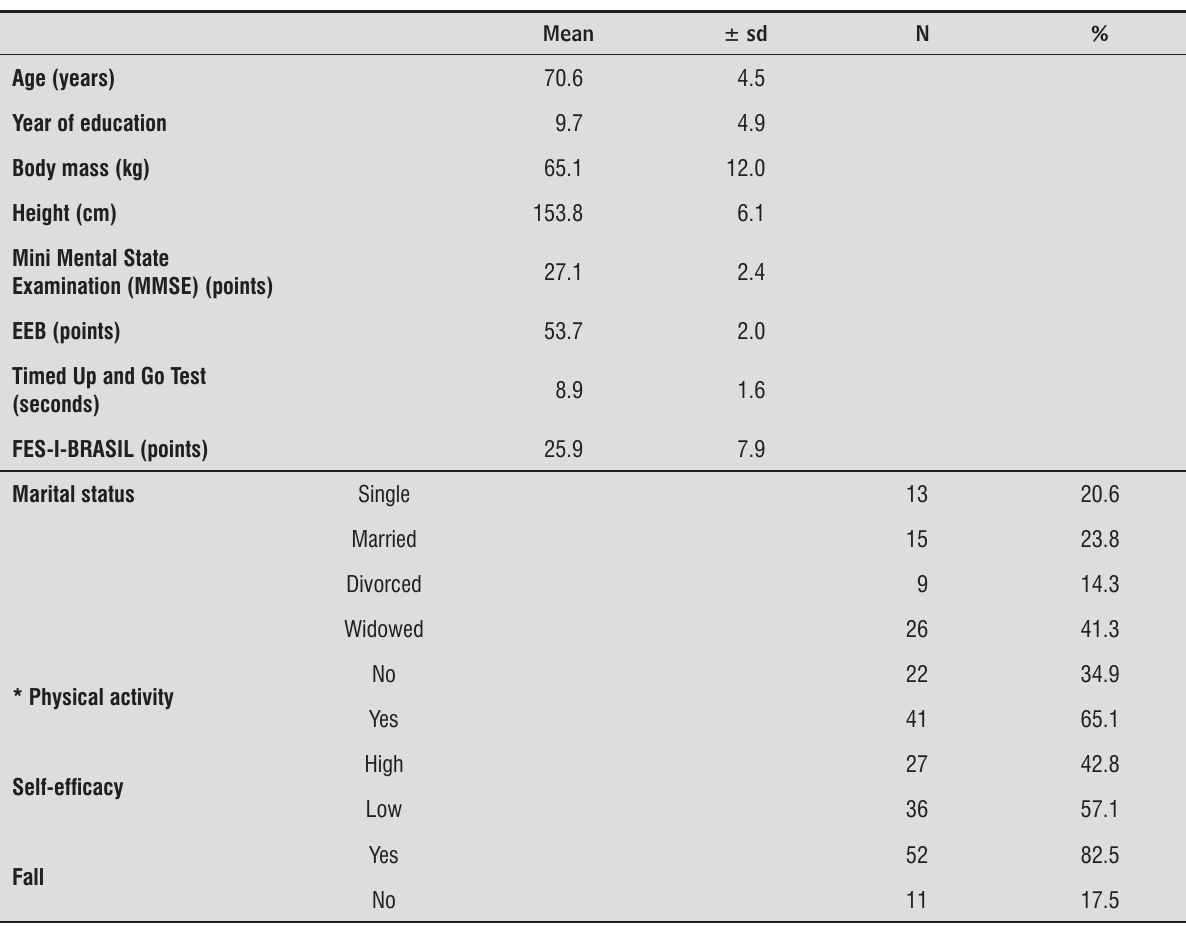
Table 1 - Characteristics of the sample of 63 Community-dwelling elderly women of Natal, RN, 2012